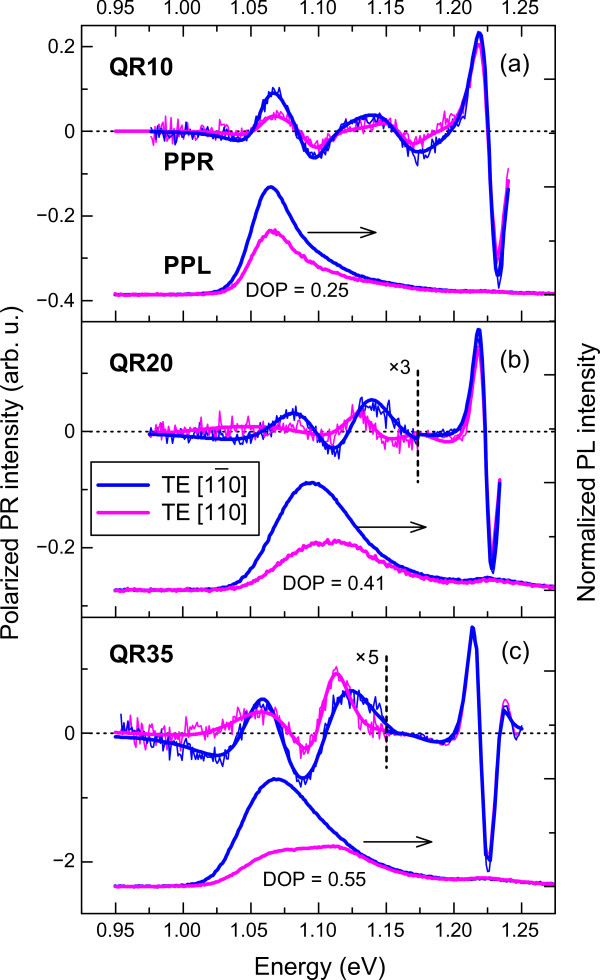
Room temperature PPR and PPL spectra in the (001) plane for the As2-grown QR samples. (a) QR10, (b) QR20, and (c) QR35. PPL optical anisotropy of the GS interband transitions in the QRs is indicated by the DOP values.